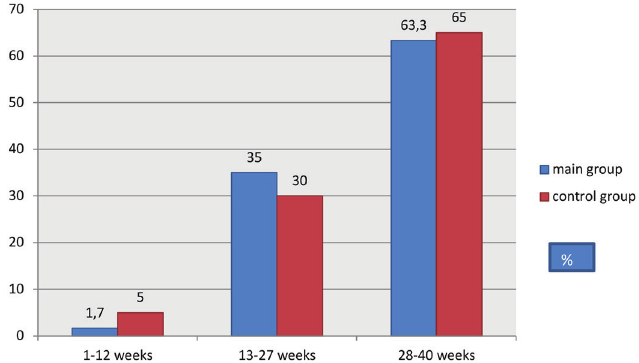
Figure 1 - Distribution of women depending on the duration of pregnancy